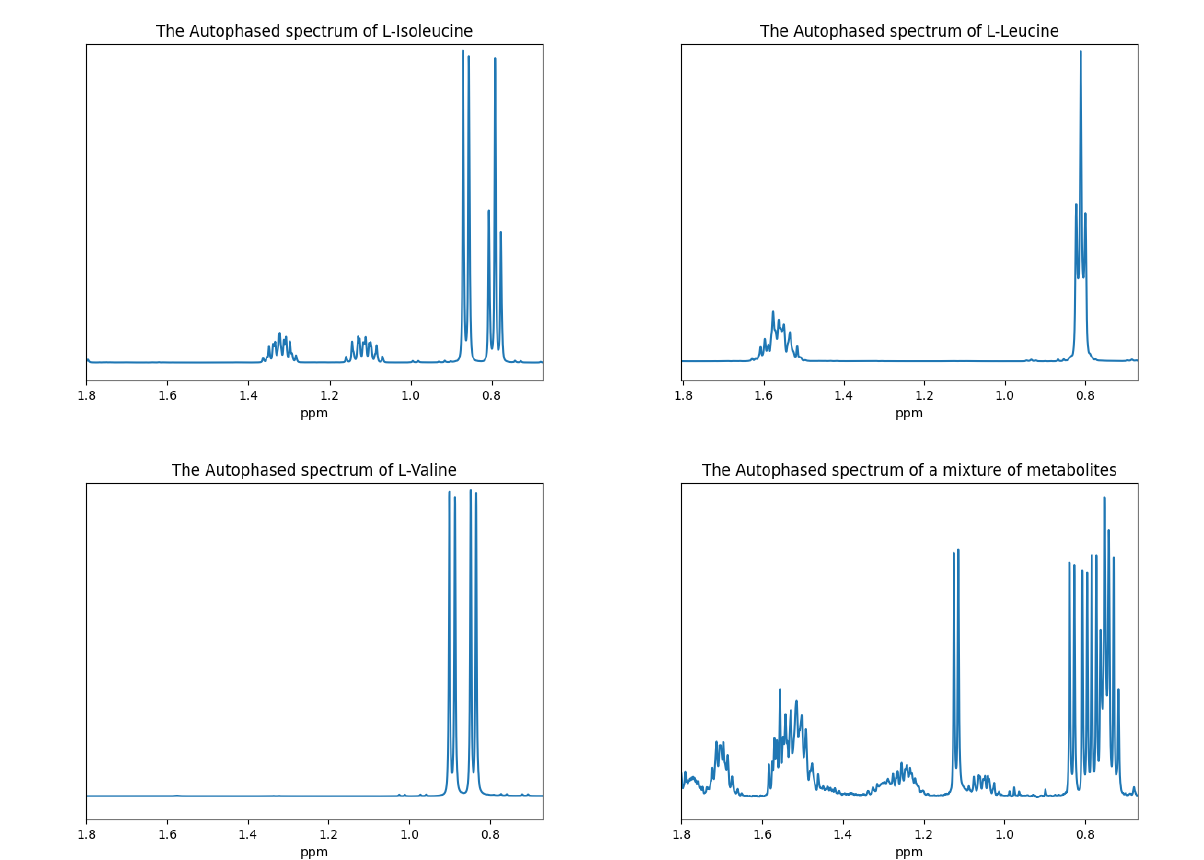
Figure 2. The autophased spectrum of four NMR experiments: ( top left ) experiment containing only L -Isoleucine, ( top right ) experiment containing only L -Leucine, ( bottom left ) experiment containing only L -Valine, and ( bottom right ) experiment containing a mixture of L -Isoleucine, L -Leucine, L -Valine, and other metabolites. Autophasing is discussed in Section